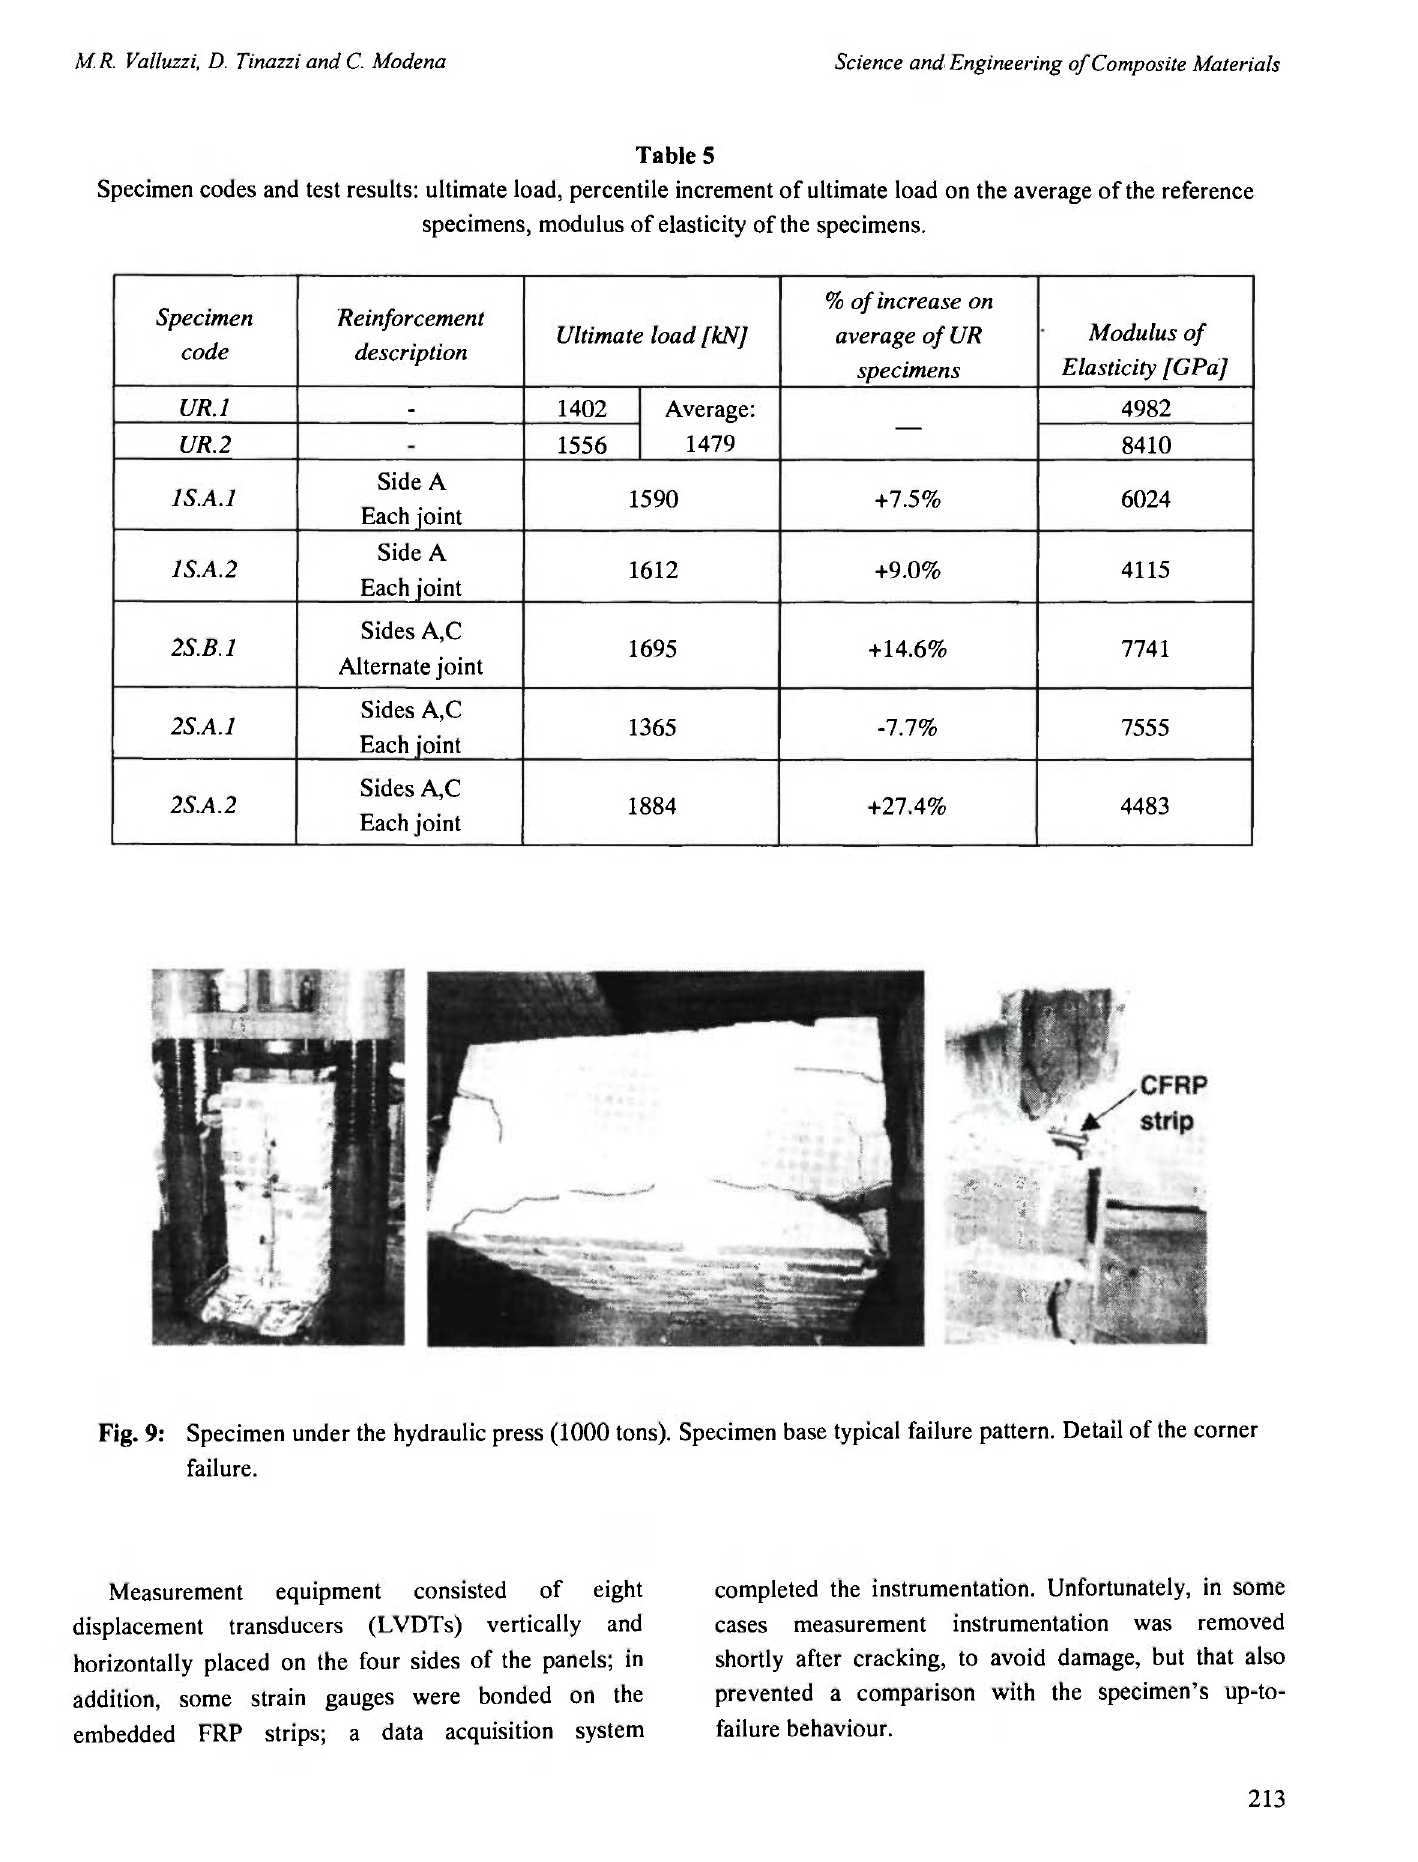
Specimen codes and test results: ultimate load, percentile increment of ultimate load on the average of the reference